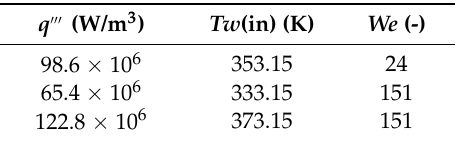
Table 4. Parameters of the conducted